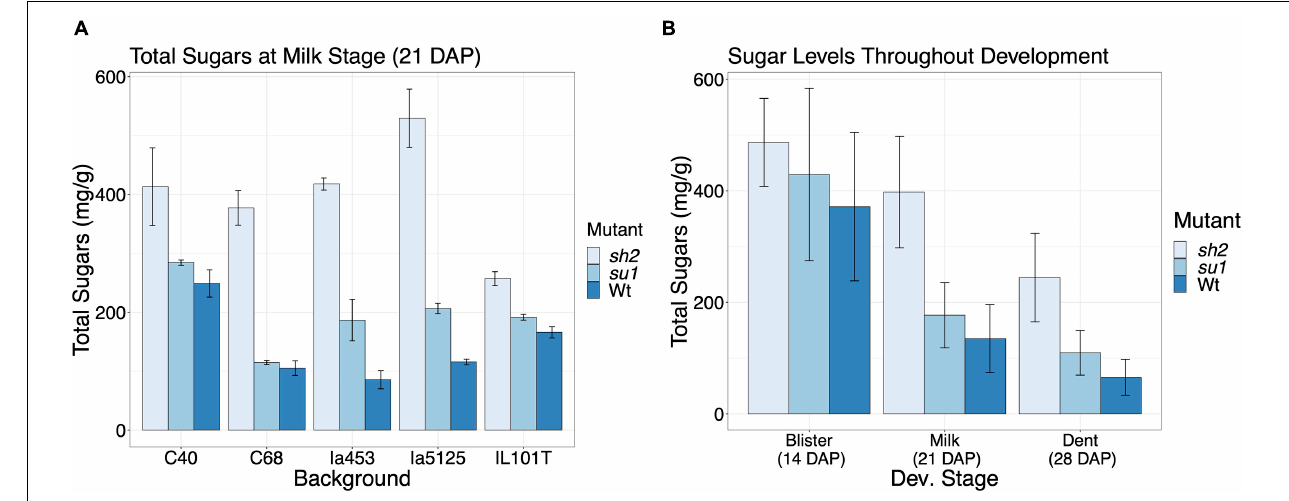
FIGURE 1 | Sugar levels across NILs. (A) Comparison of sugar levels in different NILs at milk stage (21 DAP). Values represent the mean sum of sucrose, glucose, and fructose in percent of the dry tissue weight ± SE. (B) Comparison of sugar level in different mutants at different developmental stages. Values represent the mean sum of sucrose, glucose, and fructose across genotypes in percent of the dry tissue weight ±